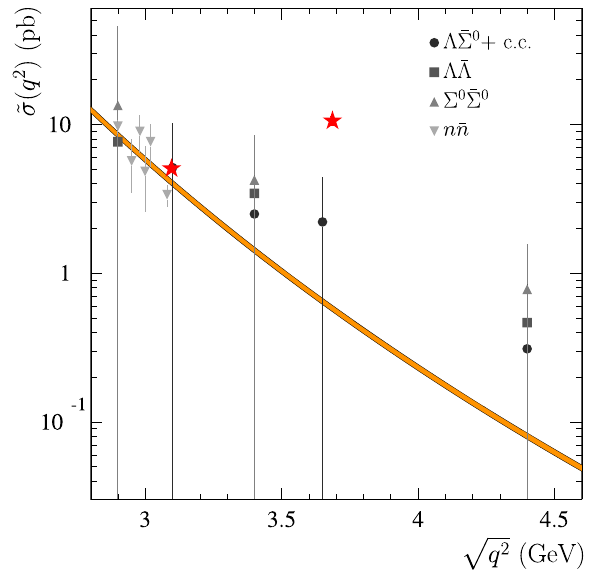
Fig. 2 The solid points are the data on the scaled cross section from BESIII [6] and BABAR [7], the orange band represents the fit results including the errors, while the red stars indicate the values of the scaled cross section at the J /ψ and ψ( 2 S ) masses derived by the BRs of the corresponding decays J /ψ → (cid:3)(cid:4) 0 + c.c. and ψ( 2 S ) → (cid:3)(cid:4) 0 +